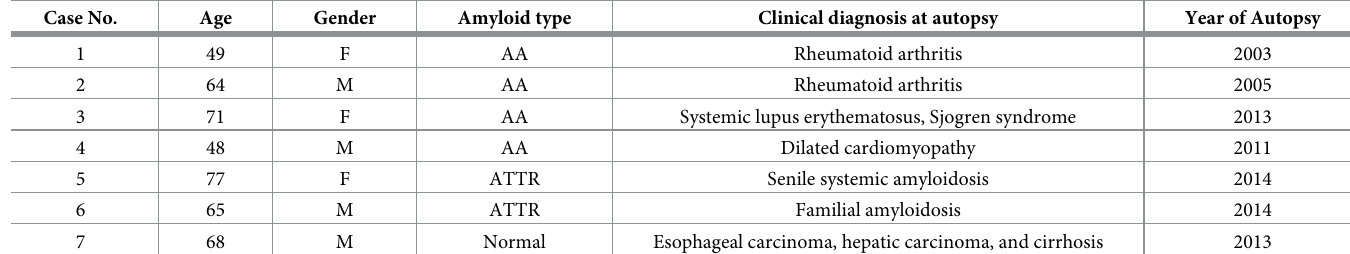
Table 2. Demographic features of patients with AA and ATTR amyloidosis and those without amyloidosis. Case